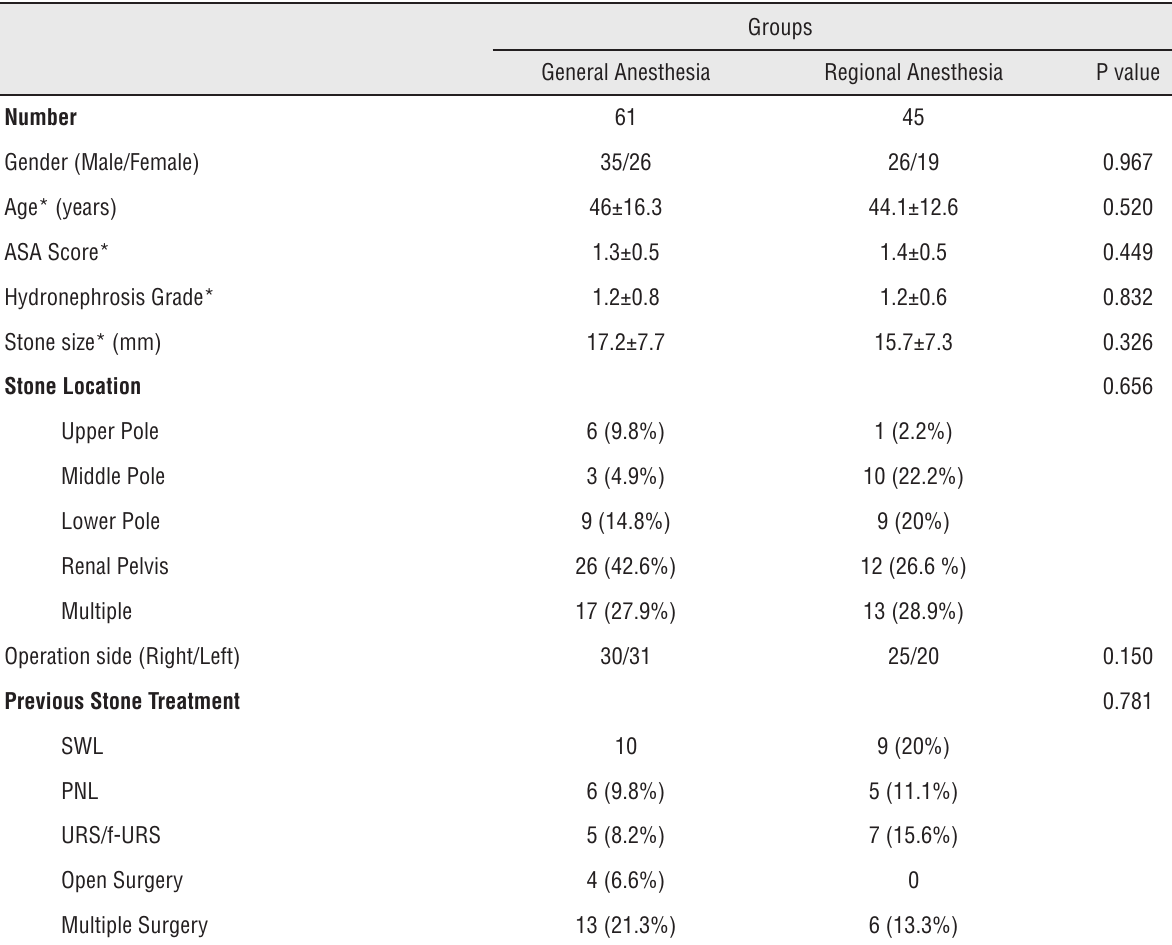
Table 1 - Comparison of preoperative demographic data of patients.